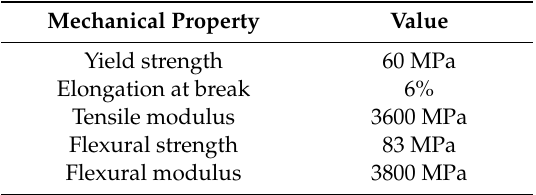
Table 1. Mechanical properties of polylactic acid (PLA).